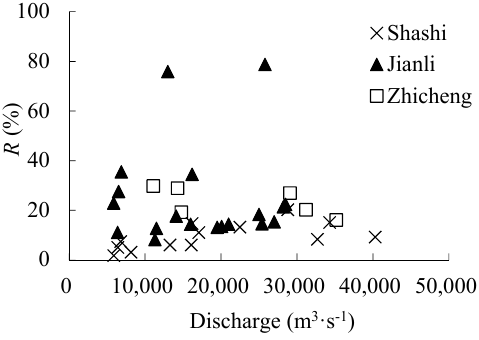
Figure 11. Contribution of the near-bed load on sediment flux.